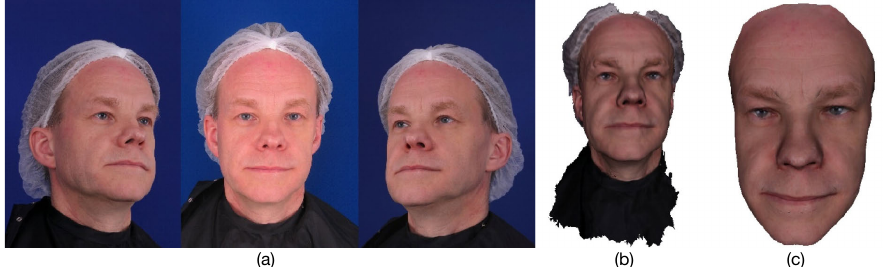
Figure 5. The neutral expression part of the ESRC image dataset. ( a ) From left to right is the left, center and right viewpoint images. ( b ) Raw data from depth camera. ( c ) The groundtruth of front